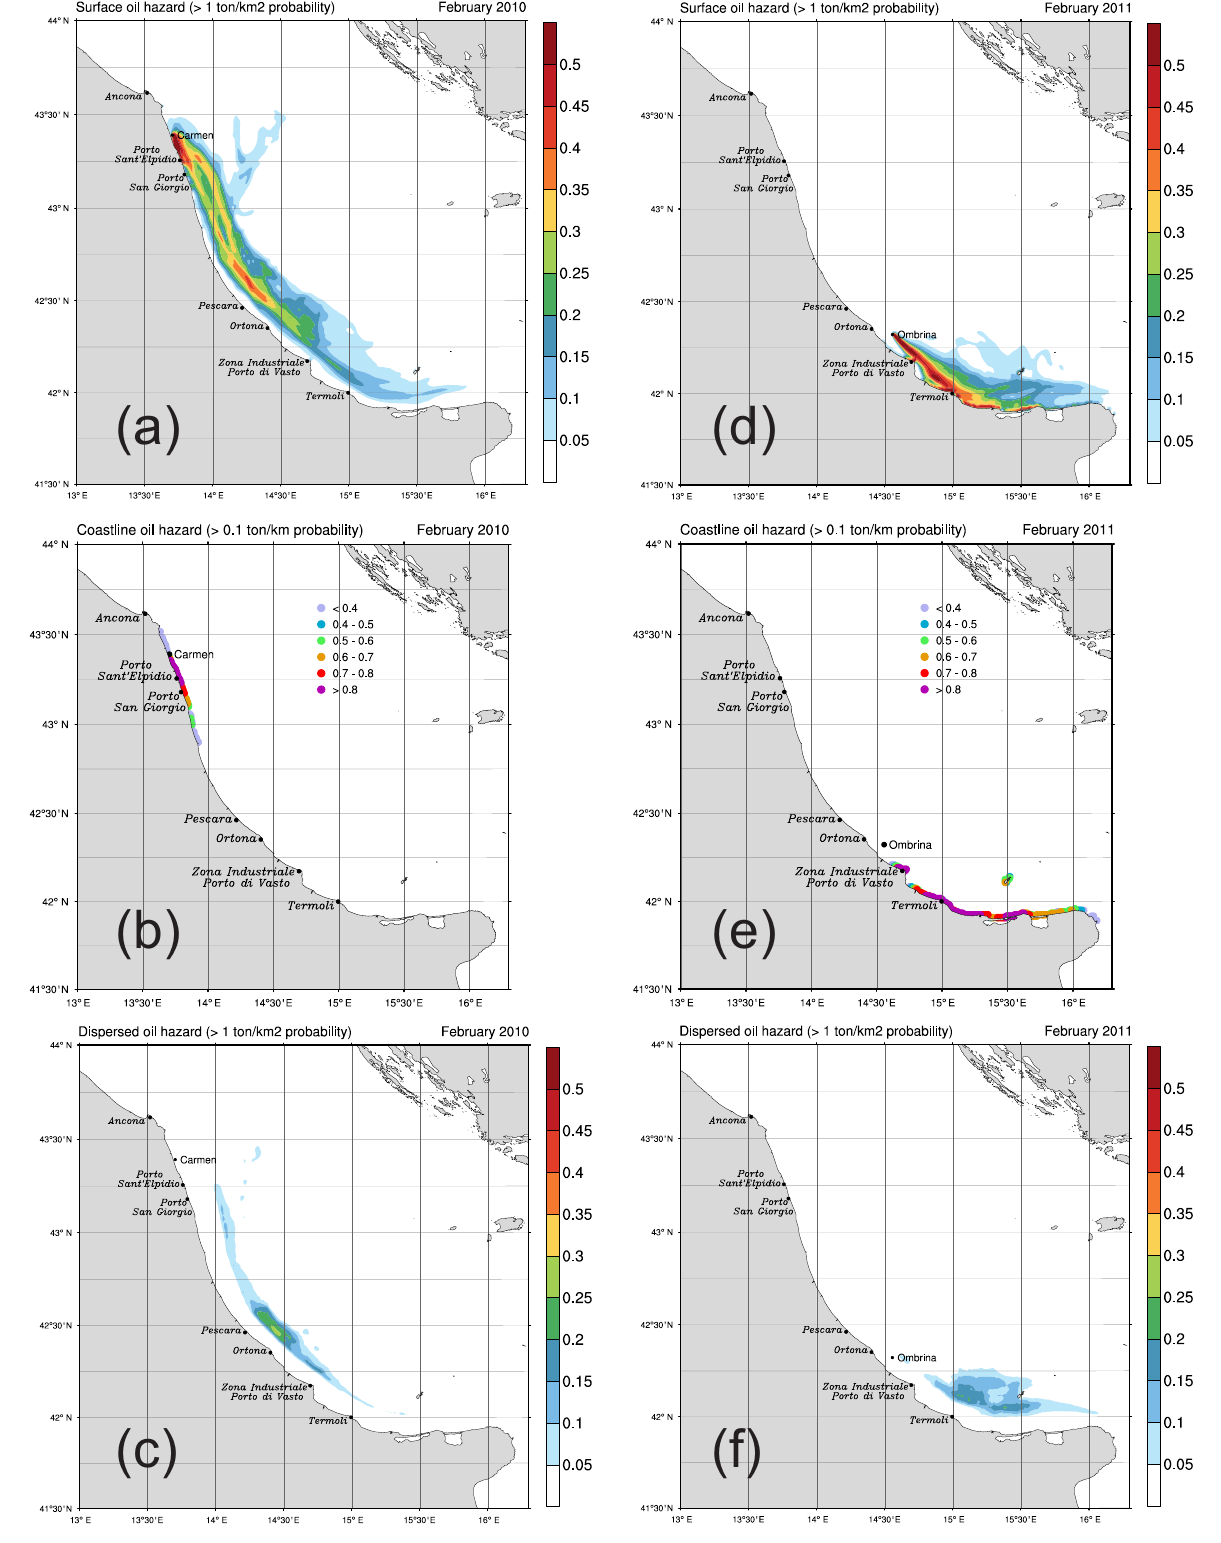
Figure 11. Monthly averaged hazard maps for the Carmen oil platform in February 2010 (left panel): at the sea surface (a) , on the coast- line (b) , for the dispersed oil (c) ; and Ombrina oil platform in February 2011 (right panel): at the sea surface (d) , on the coastline (e) , for the dispersed oil (f)